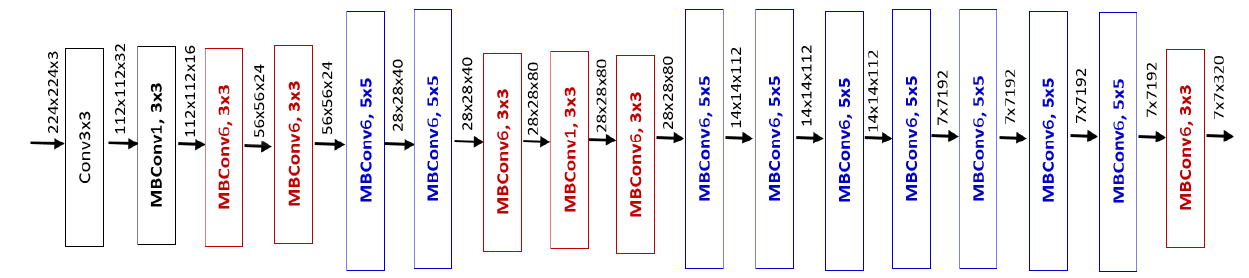
Figure 2. The EfficientNet-B2 Architecture. The numeric value next to MBConv indicates a multi- plication factor for the input channels. For example, MBConv6 means the output channel size is 6 times the input channel size. Labels in the form of a × b represent kernel size [32].